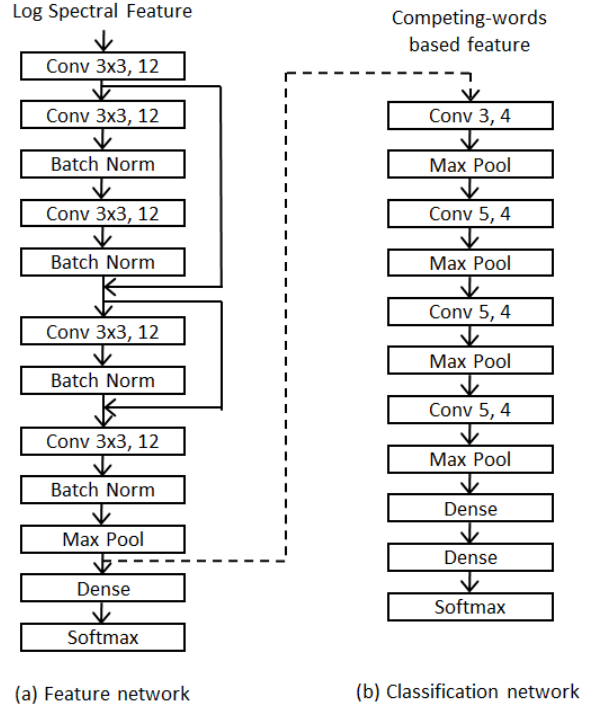
Figure 1. Configurations of the DNN (Deep Neural Networks) for the proposed WUW (wake-up-word) recognition system: ( a ) feature generation network and ( b ) classification network.